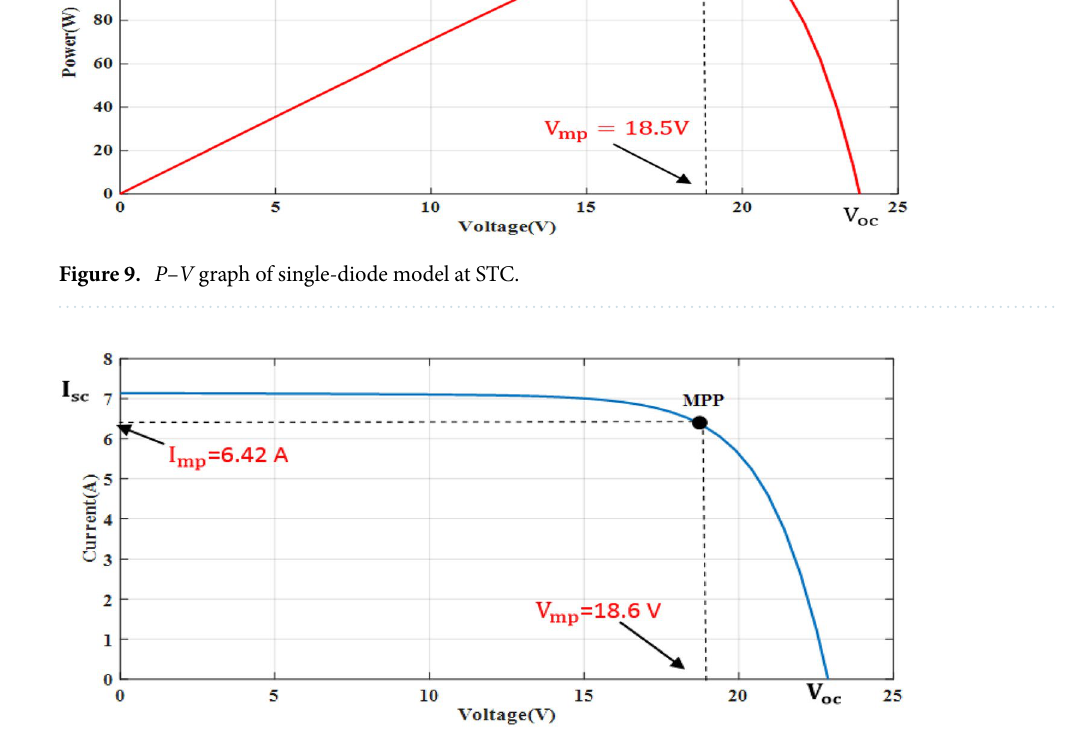
Figure 10. I – V graph of double-diode model at